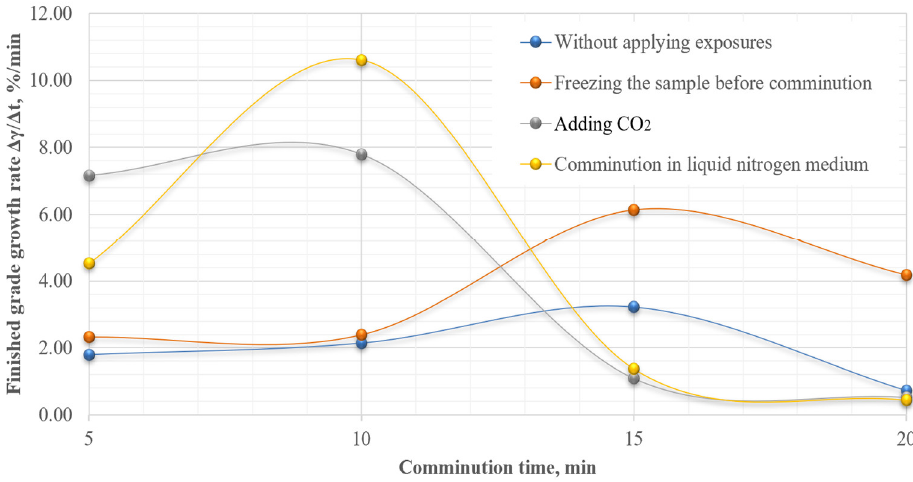
Figure 9. Dependence of finished grade growth rate on comminution time.